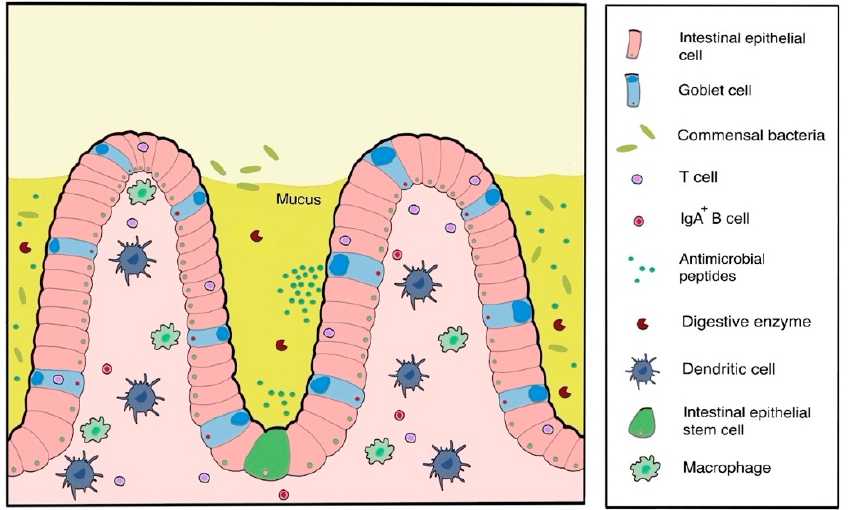
Figure 3. One of the major structural barriers for oral drug delivery is the intestinal lining that comprises of a number of factors, such as digestive enzymes, that can affect the bioavailability of administered polypeptides.